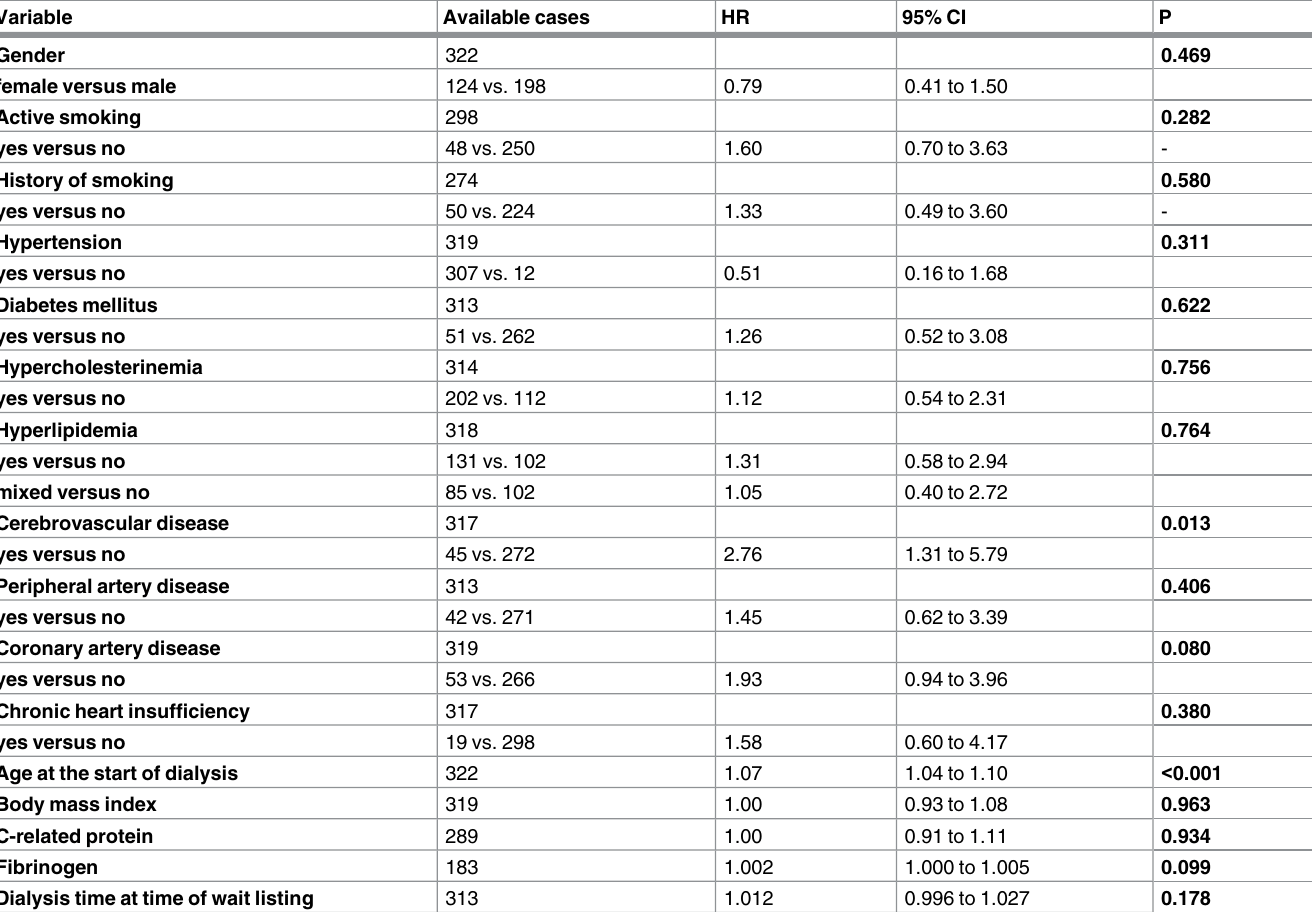
Table 3. Univariable analysis for event-free survival assessing potential risk